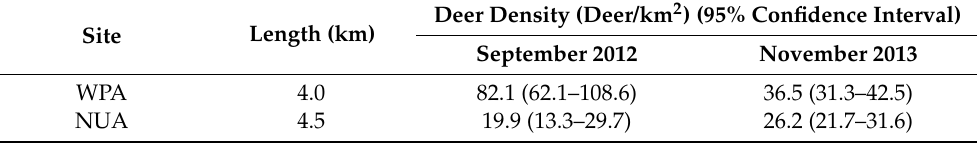
Table 3. Estimated deer density and confidence interval at sites in a wildlife protected area (WPA) and the neighboring unprotected area (NUA) from 2012 to